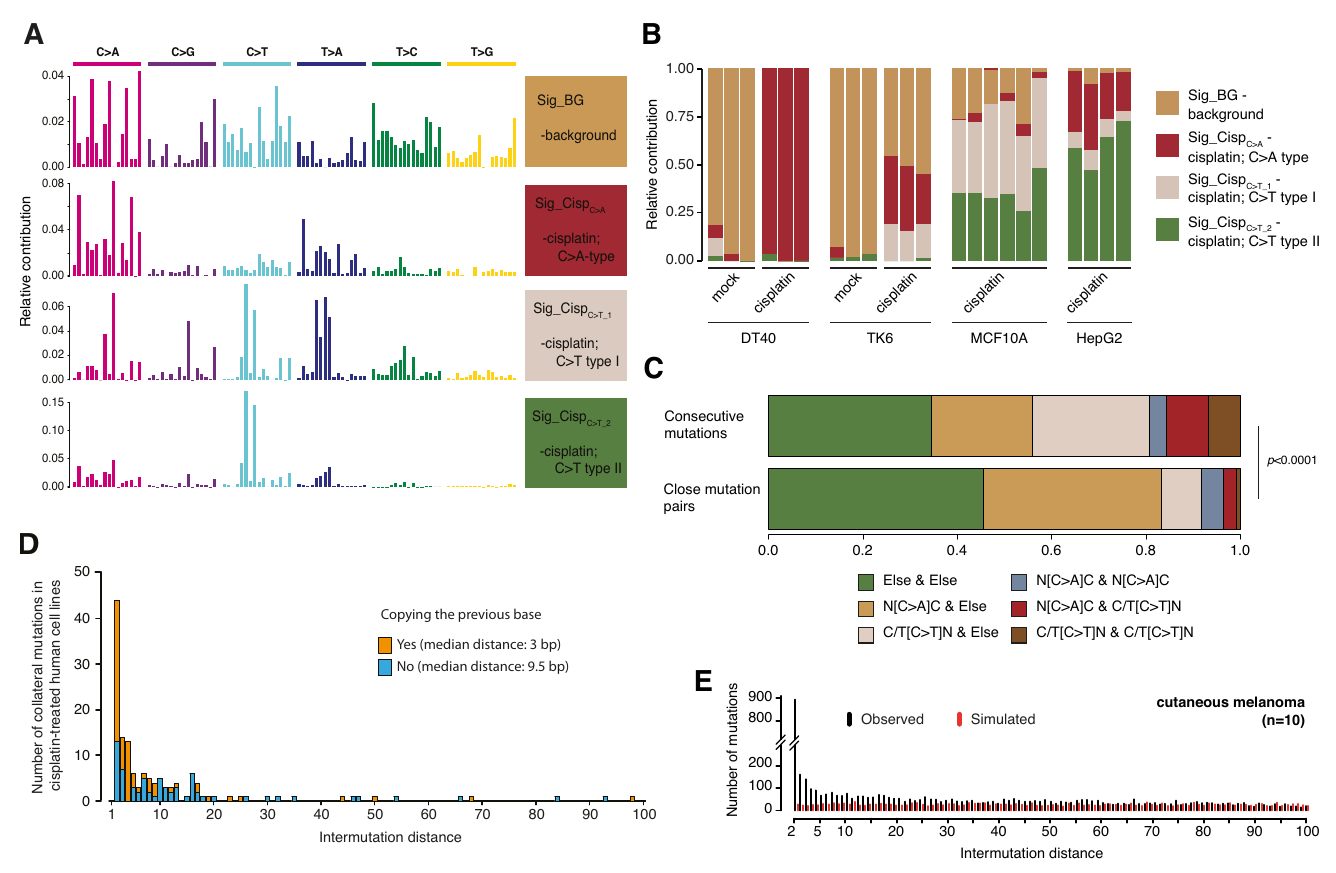
Fig 3. Collateral mutations in human cells exposed to cisplatin or UVC. (A,B) Spectra and relative contributions of components identified by de novo NMF on cisplatin-treated DT40 and human cell lines, with mock treatments included where available. (C) Distributions of different mutation category combinations among all distant mutation pairs, i.e. those that are separated by more than 100 bp (top bar) and close pairs (bottom bar). Categories were defined based on mutation classes N [C > A]C (main feature of Sig_Cisp C > A ), C/T[C > T]N (main feature of both Sig_Cisp C > T_1 and Sig_Cisp_ C > T_2 ), and all other substitutions. (D) Intermutation distances in cisplatin-treated human cell lines, categorised according to whether the variant allele of the collateral mutation is identical to the upstream base. Only mutation pairs consisting of a N[C > A]C-type primary event and another substitution are considered. (E) Intermutation distance distribution of all close mutation pairs in 10 selected melanoma samples (black), compared to an expected distribution generated by randomly simulating the same number of mutations for each sample (red).